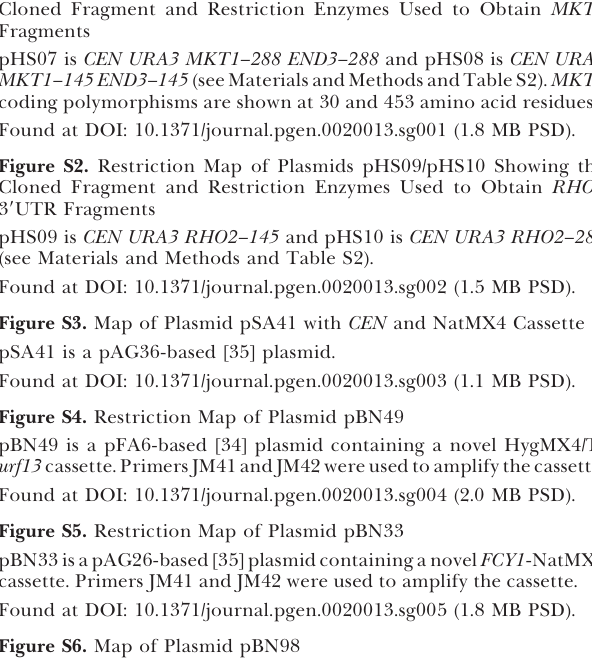
Figure S1. Restriction Map of Plasmids pHS07/pHS08 Showing the Cloned Fragment and Restriction Enzymes Used to Obtain MKT1 Fragments